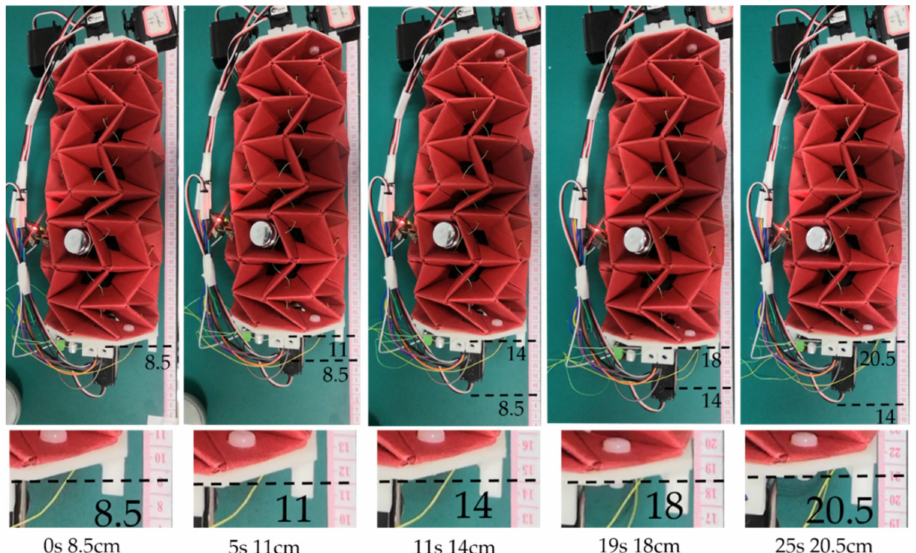
Figure 18. Top view of the forward motion of the origami crawling robot with rubber sliding feet.